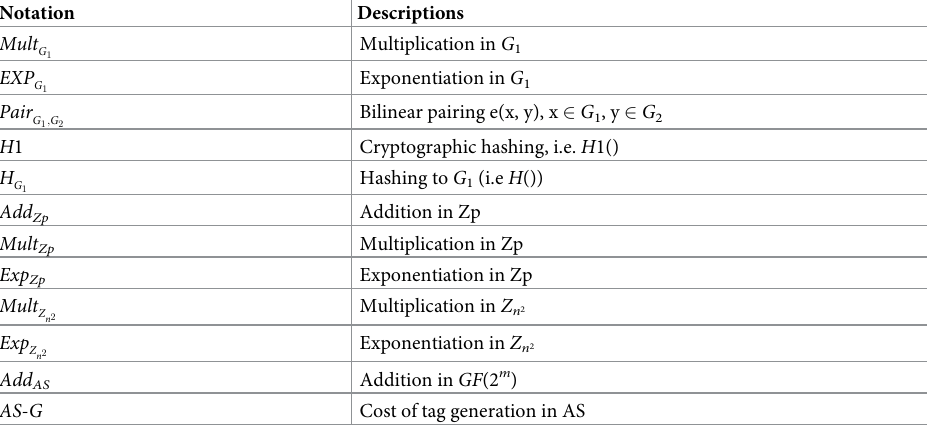
Table 7. Basic operations: Symbols and